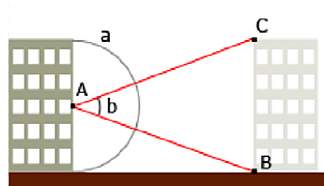
Figure 3. Code for line tool used for the windows visibility analysis